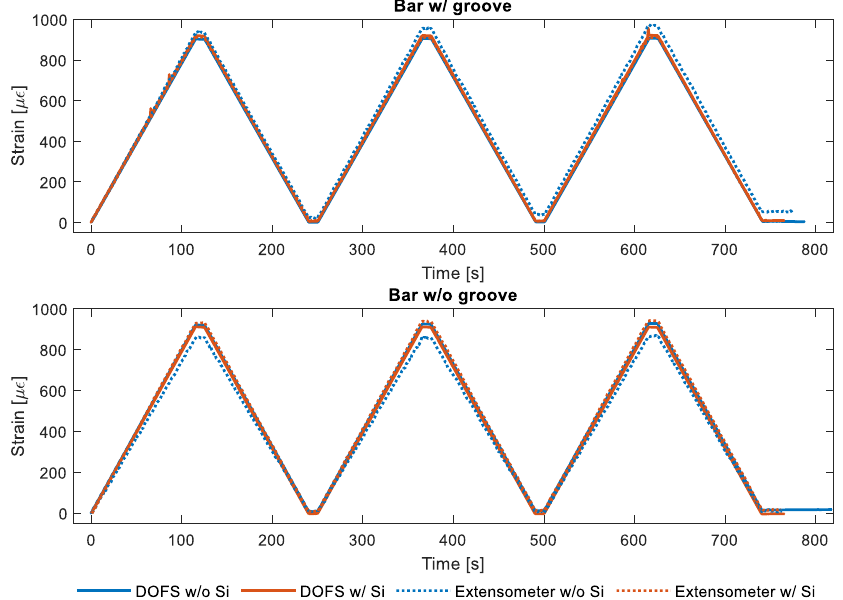
Figure 7. DOFS and extensometer output readings of the tensile test.